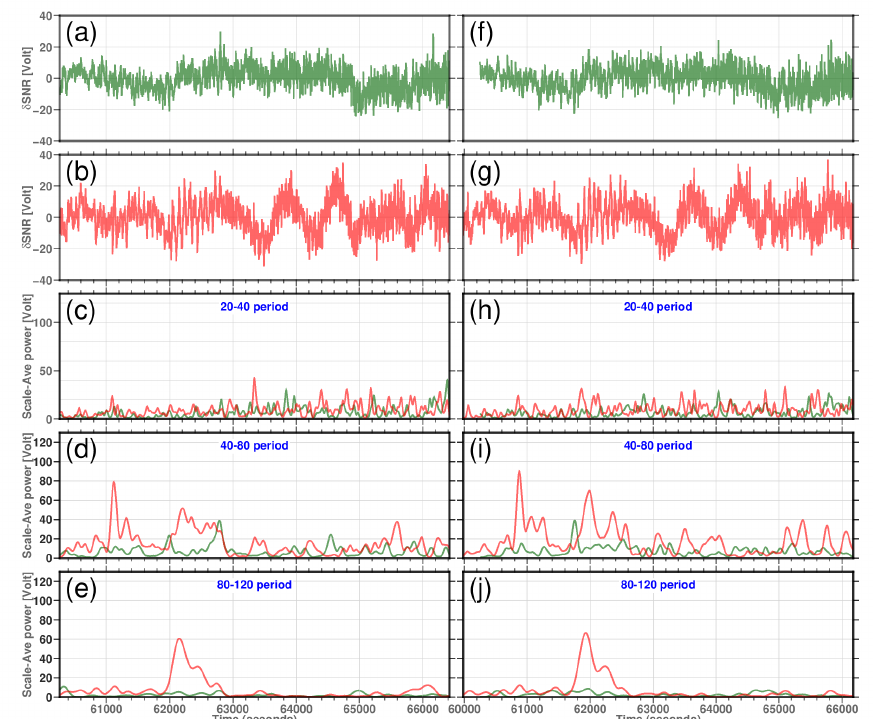
Figure 14. The Morlet wavelet analysis of δ SNR for an ascending arc of GPS satellite PRN27 on 1 March 2021. ( a , b ) δ SNR time series (solid light green line) for station KBG1 for days of the year (DoYs) 60 and 61, respectively. ( c , d ) δ SNR time series (solid light red line) for station KBG2 for doYs (cid:16) | ( W (cid:17) n ( s ) | ) 2 60 and 61, respectively. ( e , f ) Scaled averaged wavelet power for all scales, which appears s in the 20–40 s period band for stations KBG1 and KBG2 for DoYs 60 and 61, respectively. ( g , h ) Scaled averaged wavelet power for all scales, which appears for the period 40–80 s for both stations during DoYs 60 and 61, respectively. The maximum powers for station KBG2 appear at 61,118 s and 60,872 s for DoYs 60 and 61, respectively. A second peak with diminished power also appears for KBG2. For KBG1, the maximum powers appear at 62,786 and 61,754 s for the DoYs 60 and 61, respectively, with much-reduced power compared to KBG2. ( i , j ) Scaled averaged wavelet power for all scales, which appear in the 80–120 s band for both stations and for the DoYs 60 and 61, respectively. For KBG2, the maximum power occurs at 62,152 s for DoY 060 and 61,930 s for DoY